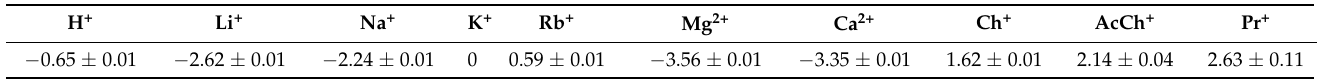
Table 1. Potentiometric selectivity coefficients, log K K,j , of the cation-selective electrode. H